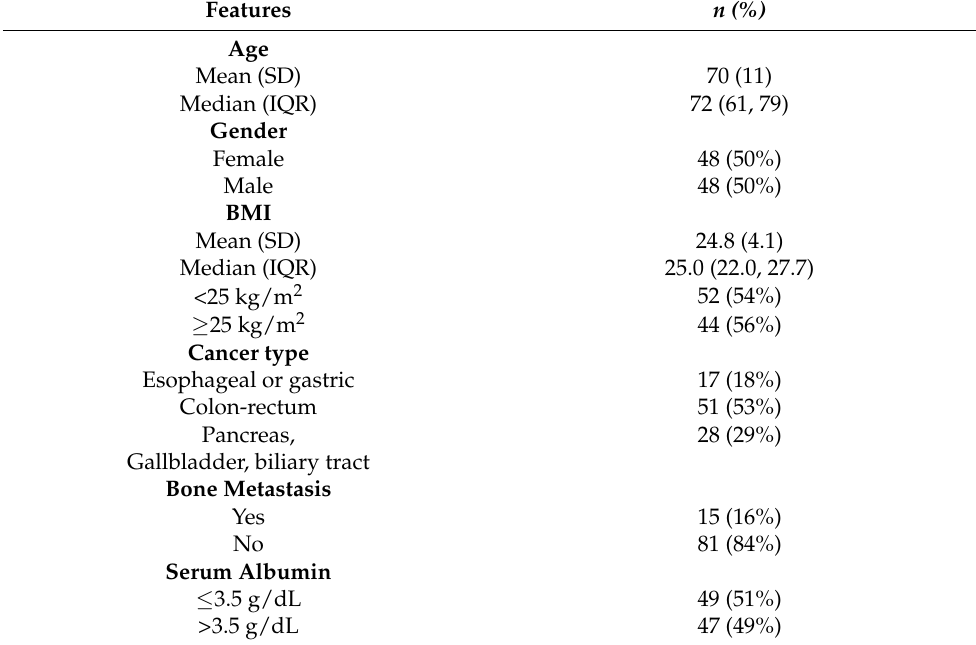
Figure 1. Study Flowchart. Demographic and clinical data are reported in Table 2. Table 2. Patients’ features ( n = 96).